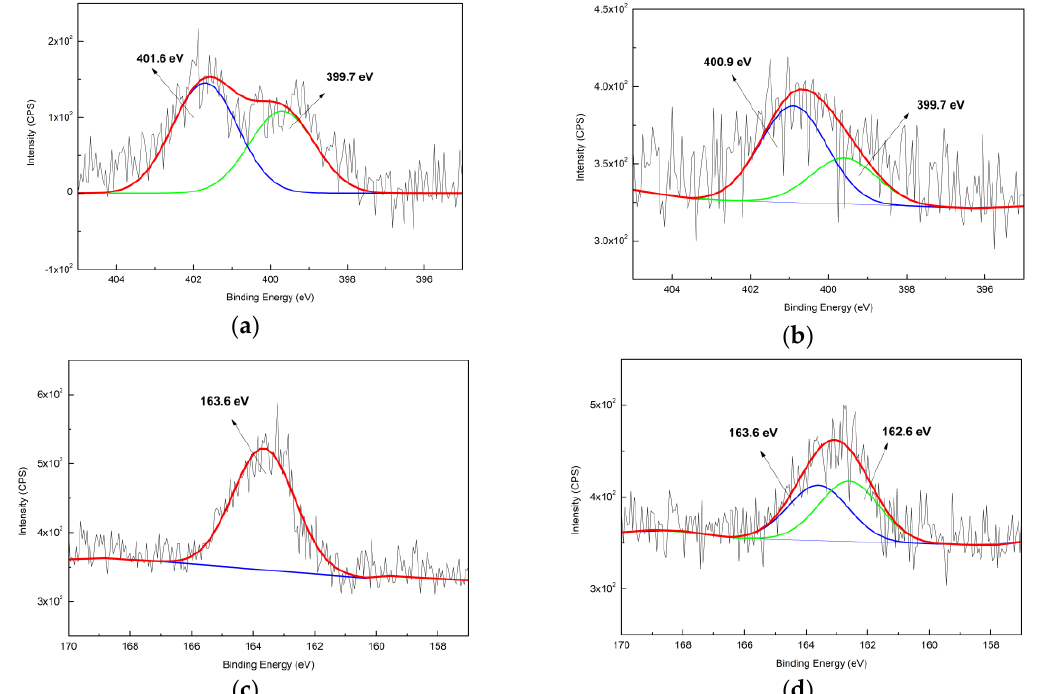
Figure 7. High resolution N 1s spectra and S 2p spectra of silane deposited zeolite and AuNPs immobilized zeolite: ( a ) N 1s of APTES deposited zeolite; ( b ) N 1s of Au@zeolite-APTES; ( c ) S 2p of MPTES deposited zeolite; ( d ) S 2p of Au@zeolite-MPTES.